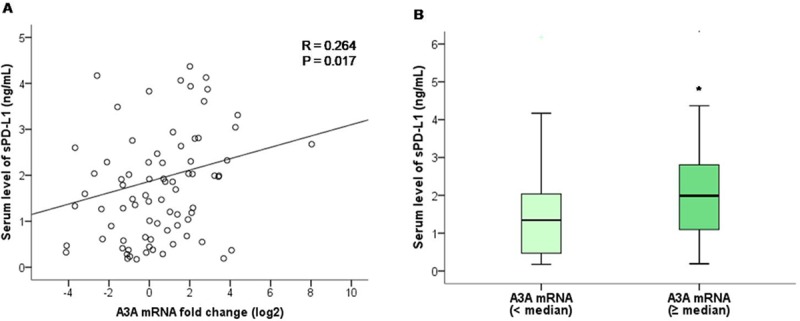
Correlation of serum sPDL-1 levels and APOBEC 3A mRNA expression levels.(A) Scatter plot graph showing a positive correlation between serum sPDL-1 levels and A3A mRNA expression levels. (B) Serum levels of sPD-L1 was higher in tumors with high A3A mRNA expression levels (≥ median) than in tumors with low A3A mRNA levels (< median) (p = 0.038). *p < 0.05, Mann-Whitney U test.